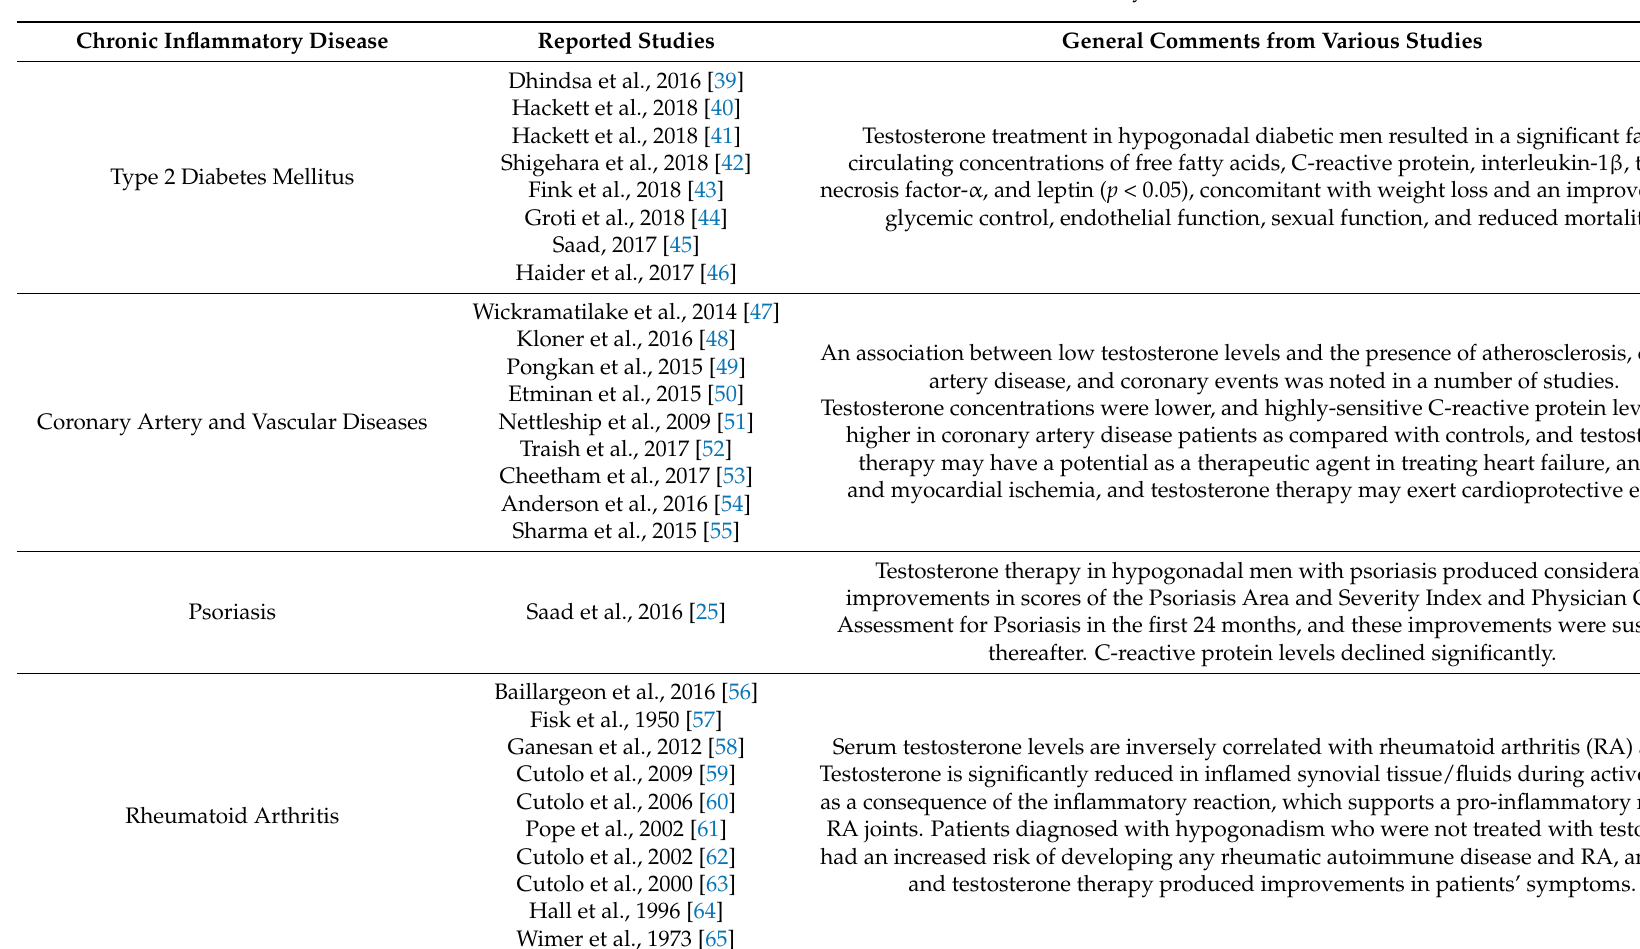
Table 3. Possible Benefits of Testosterone in Various Inflammatory